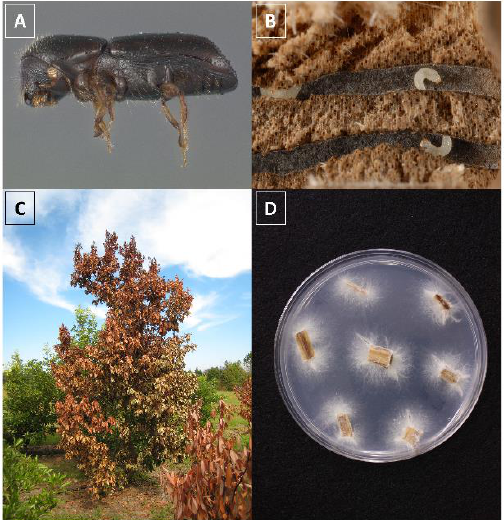
Figure 1. The redbay ambrosia beetles Xyleborus glabratus ( A ) adult female and ( B ) larvae within a (A,B): Lyle Buss, University of gallery, ( C ) wilted and recently killed redbay tree and ( D ) Raffaelea lauricola in culture. Photo credit (A,B): Lyle Buss, University of Florida.